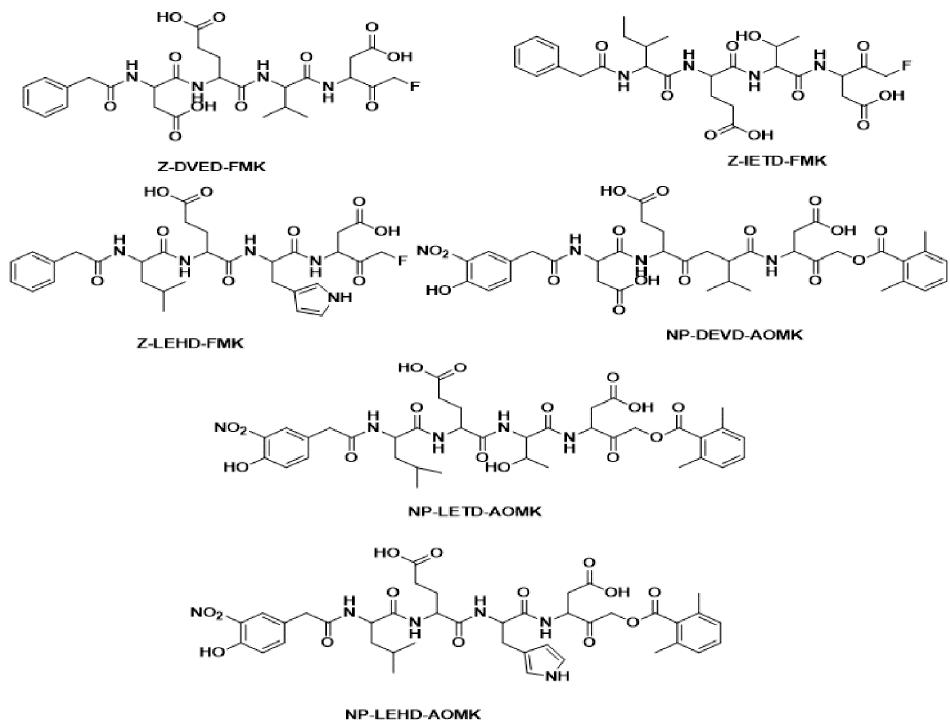
Figure 1. Structures of the training set compounds used for pharmacophore generation [26].